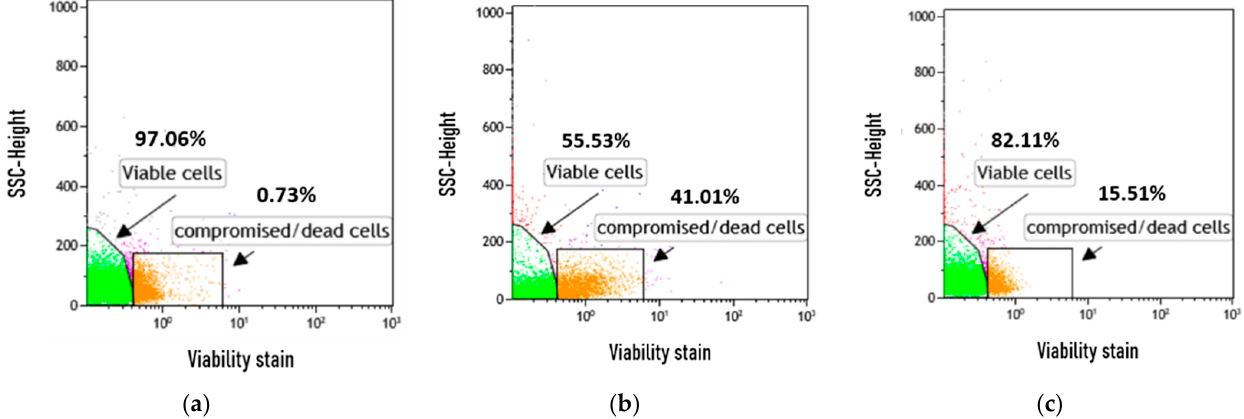
Figure 4. Flow cytometric analysis of photosensitizer-treated yeast cultures for discrimination of live from dead cells. Yeast cells were cultured in YPD medium treated with photosensitizers for 3 h and then stained with the BD Horizon Fixable Viability Stain (FVS 660). Representative FC plots of ( a ) untreated cells and treated with either ( b ) fagopyrin or ( c ) hypericin. The analysis of the in vitro assay showed that fagopyrin treatment resulted in a greater (41.01%) percentage of necrotic cells compared to hypericin treatment (15.51%).